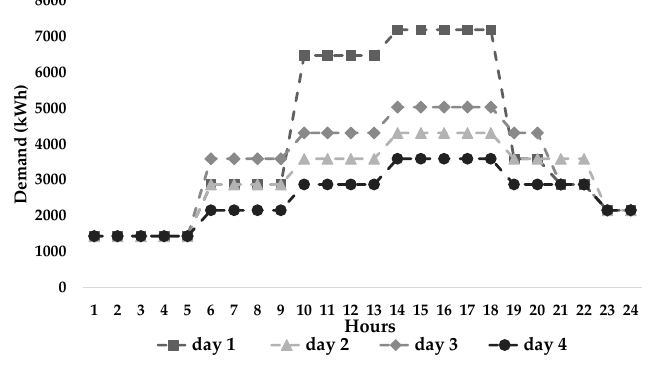
Figure 3. Demand